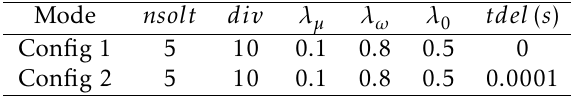
Table 1. System parameters configurations.